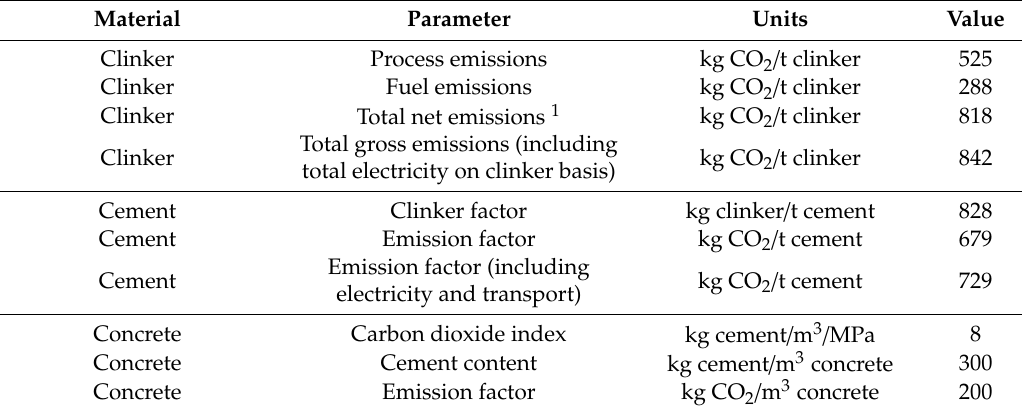
Table 3. Values of the key parameters based on the 2018 scenario (Initial hypothesis).